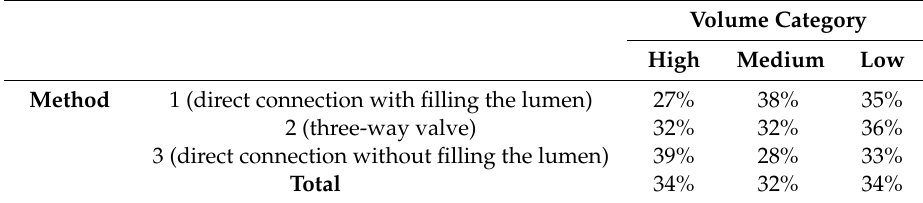
Table 7. Total volume of air depending on the method.